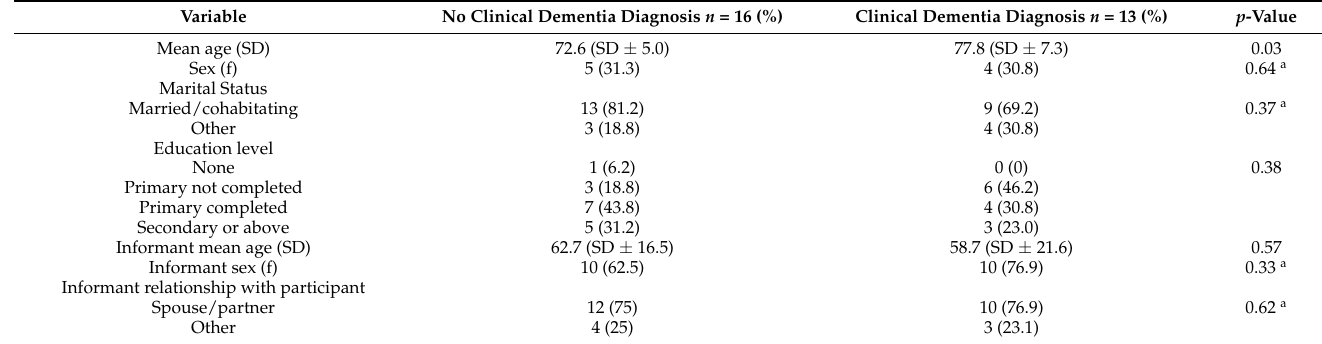
Table 3. Sociodemographic characteristics of participants and informants by reference standard clinical diagnosis. Variable No Clinical Dementia Diagnosis n = 16